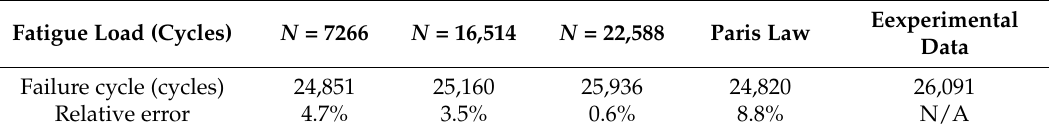
Table 9. The estimation of the failure cycle for the specimen T 3